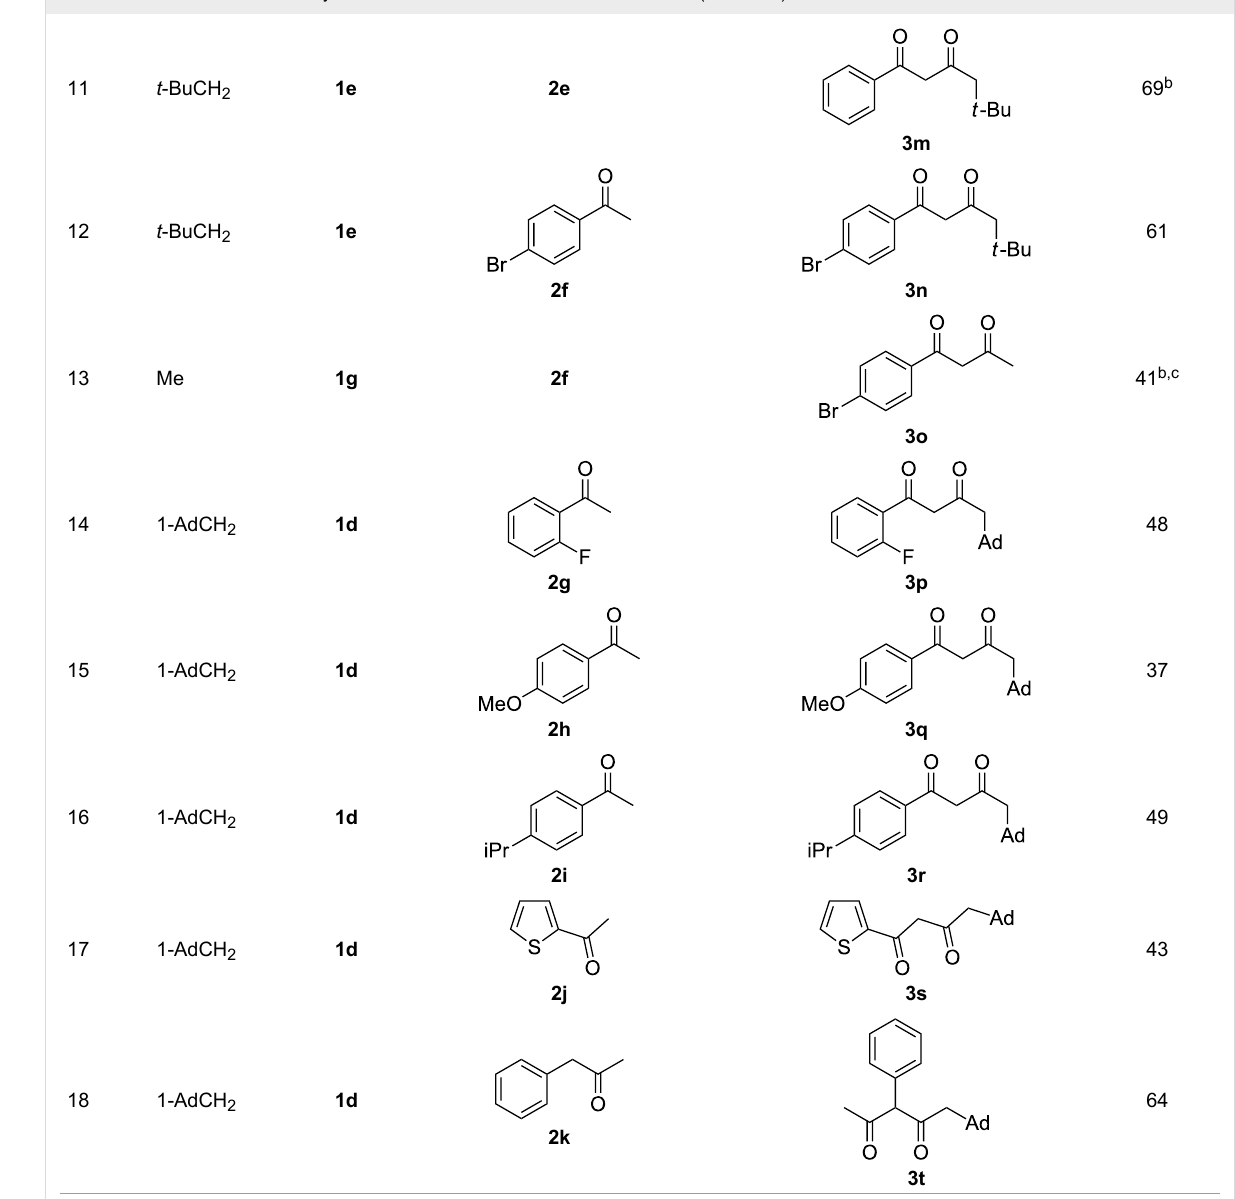
Table 2: TFAA/TfOH-mediated acylation of aromatic ketones with alkanoic acids а .